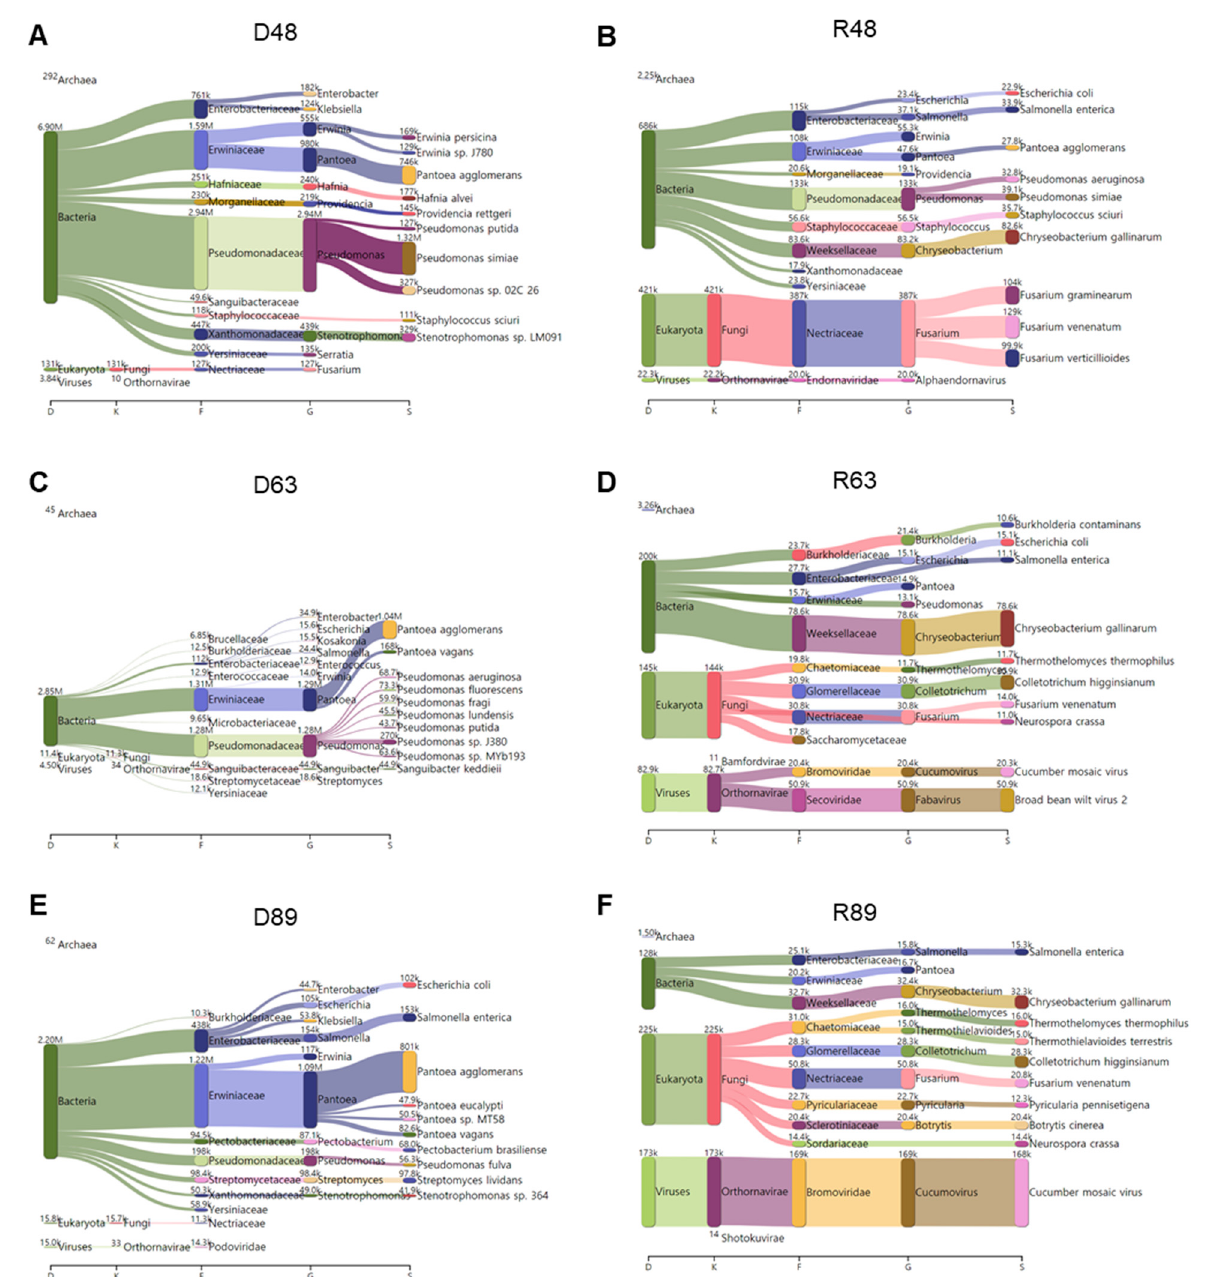
Figure 12. Major microbiomes identified from six different libraries using KRAKEN2_R. Sankey diagram displays major microbiomes in D48 ( A ), R48 ( B ), D63 ( C ), R63 ( D ), D89 ( E ), and R89 ( F ) libraries with abundance of microbial